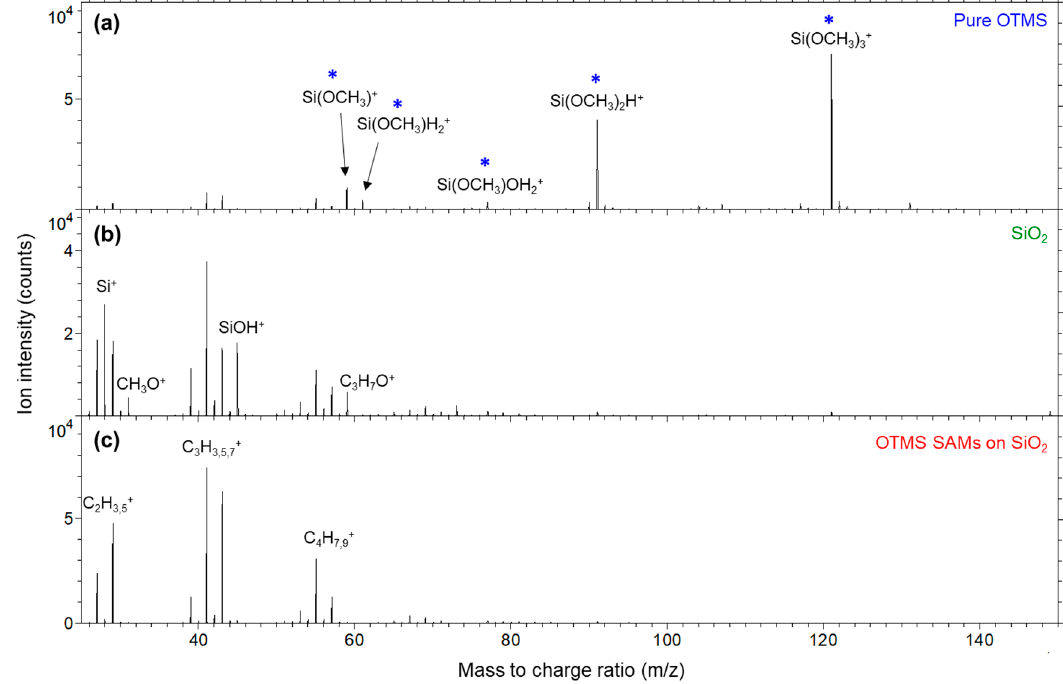
Figure 7. Positive secondary ion mass spectra ( m / z 25 ‒ 150) for ( a ) pure OTMS (placed on a polypropylene film); ( b ) a UV/ozone-treated SiO 2 substrate; ( c ) OTMS SAMs prepared on a UV/ozone-treated SiO 2 substrate. Ions indicated by a star are (*) associated with the OTMS headgroup, ‒Si(OCH 3 ) 3 .